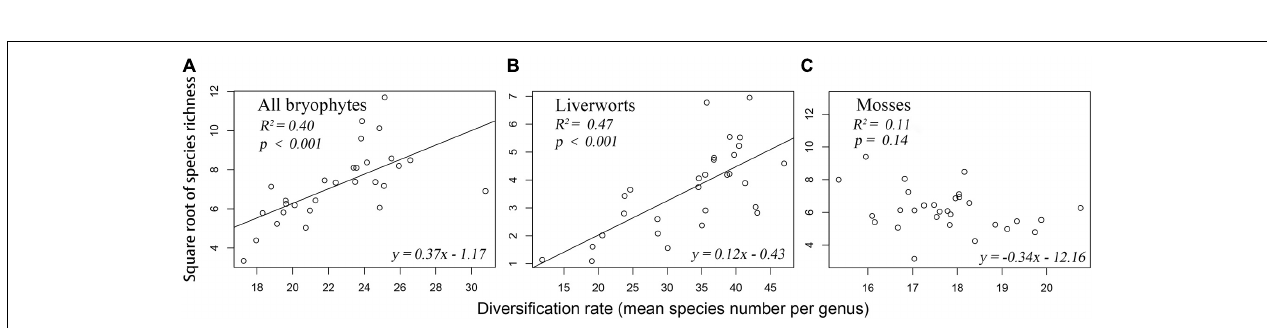
FIGURE 2 | Relationship between species richness and diversification rates of bryophyte. (A) All bryophytes (B) Liverworts (C) Mosses.